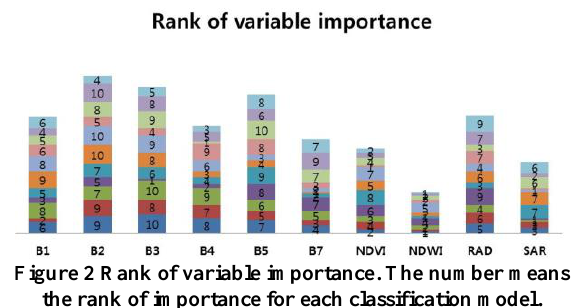
Figure 2 Rank of variable importance. The number means the rank of importance for each classification model.